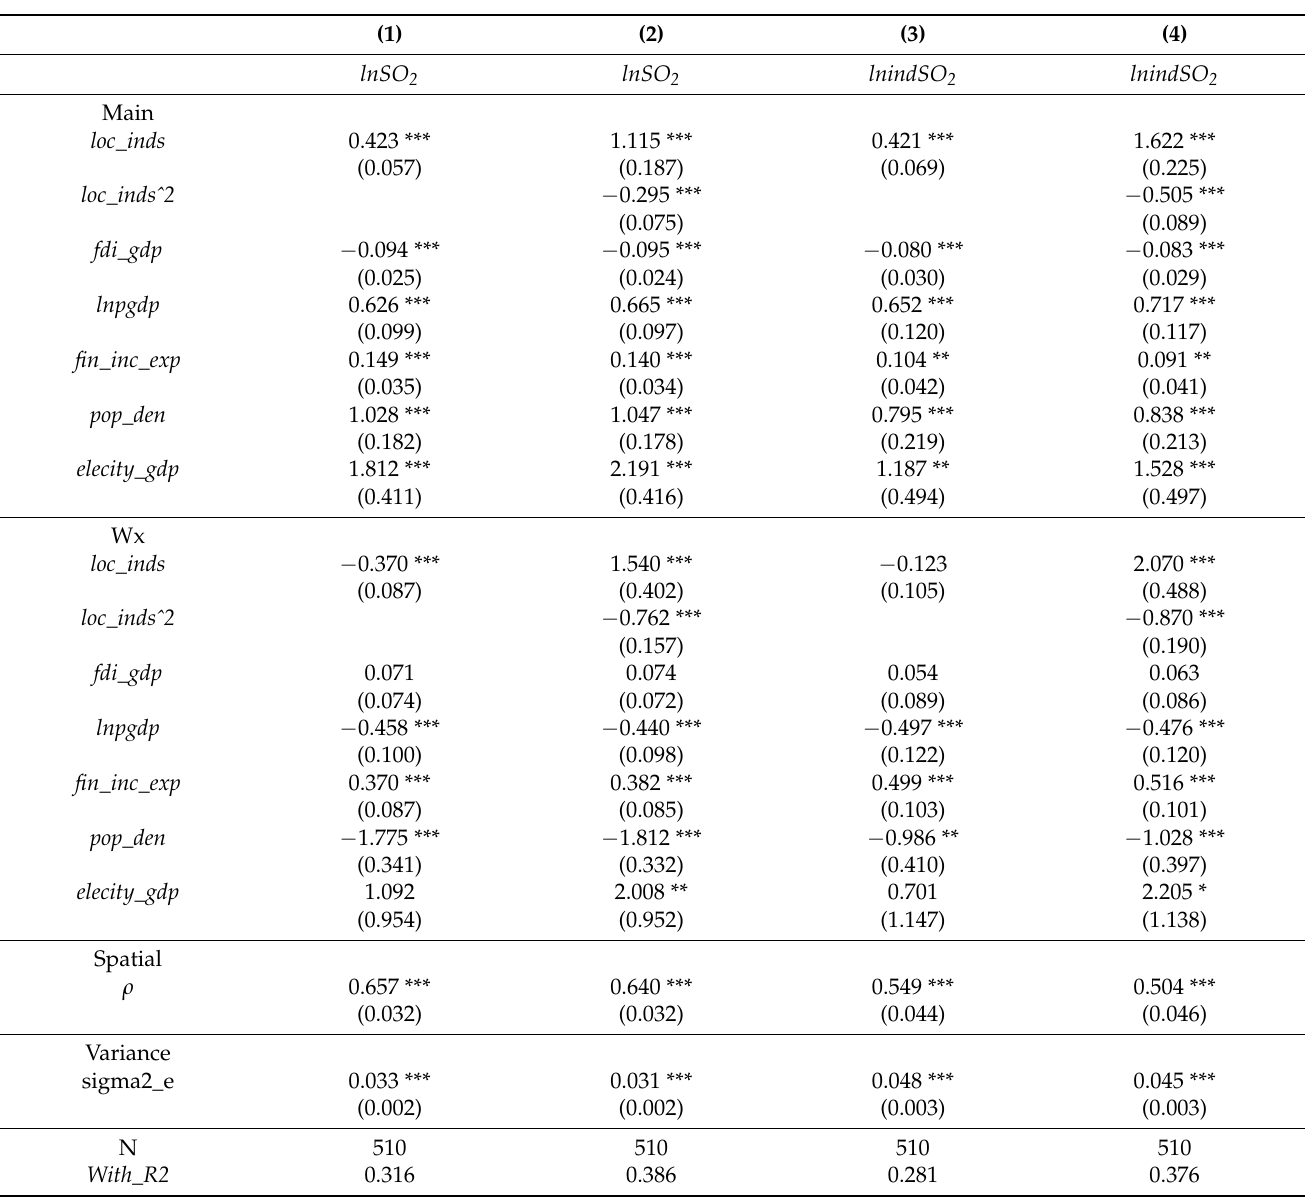
Table 4. Results of Spatial Durbin Model